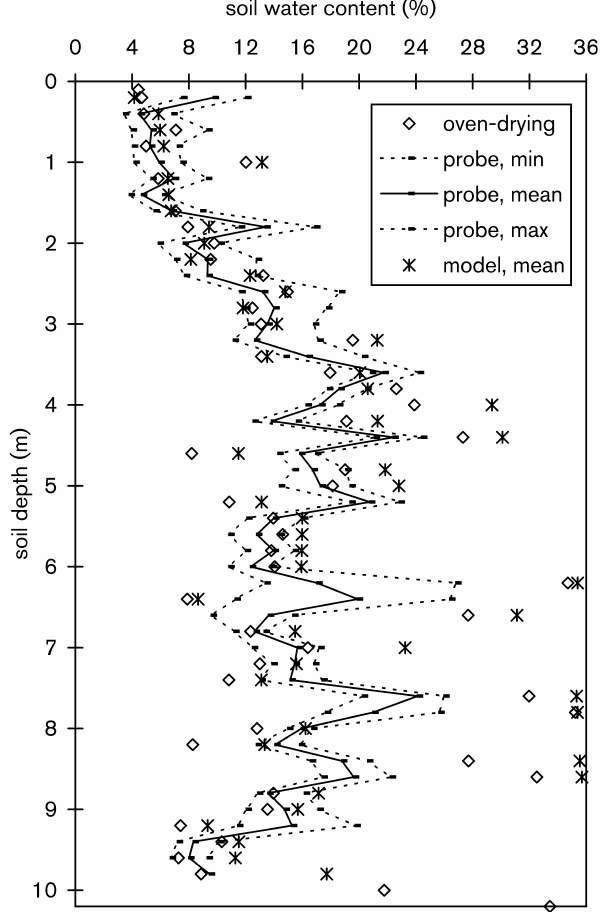
Fig. 3. Observed and simulated water contents in the soil profile that were sampled in 2003. The water content data obtained by the oven-drying method was used to calibrate the vadose zone model. The minimum, mean, and maximum values of water contents were obtained from measurements by the soil moisture probe at thirteen occasions (probe, min, mean, max), and was used for validation. The visualized mean of water content data obtained from the model (model, mean) refer to the corresponding thirteen days in the model.